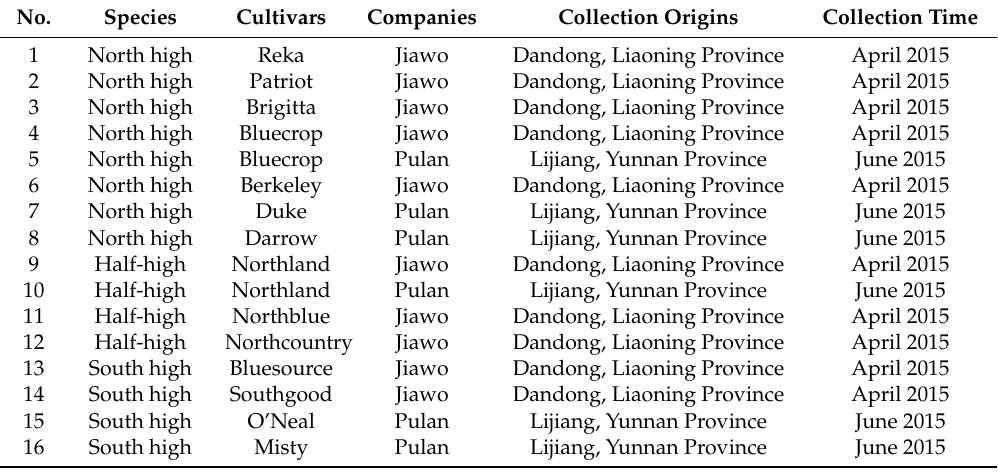
Table 1. Species, cultivars, companies, collection origins, and collection time for the 16 blueberry samples.